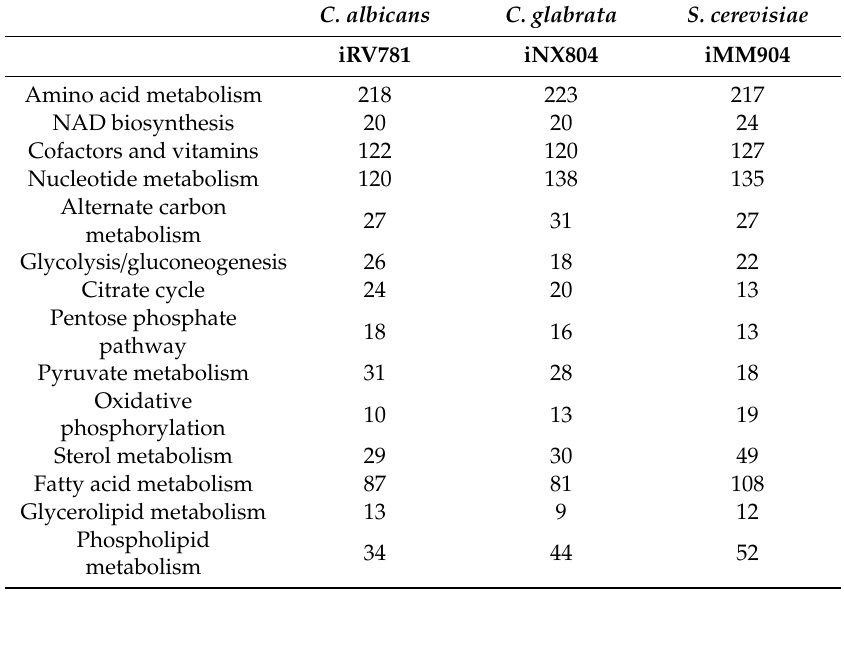
Table 1. Number of reactions in the main pathways of the C. albicans iRV781 model in comparison to C. glabrata iNX804 model and S. cerevisiae iMM904 model.